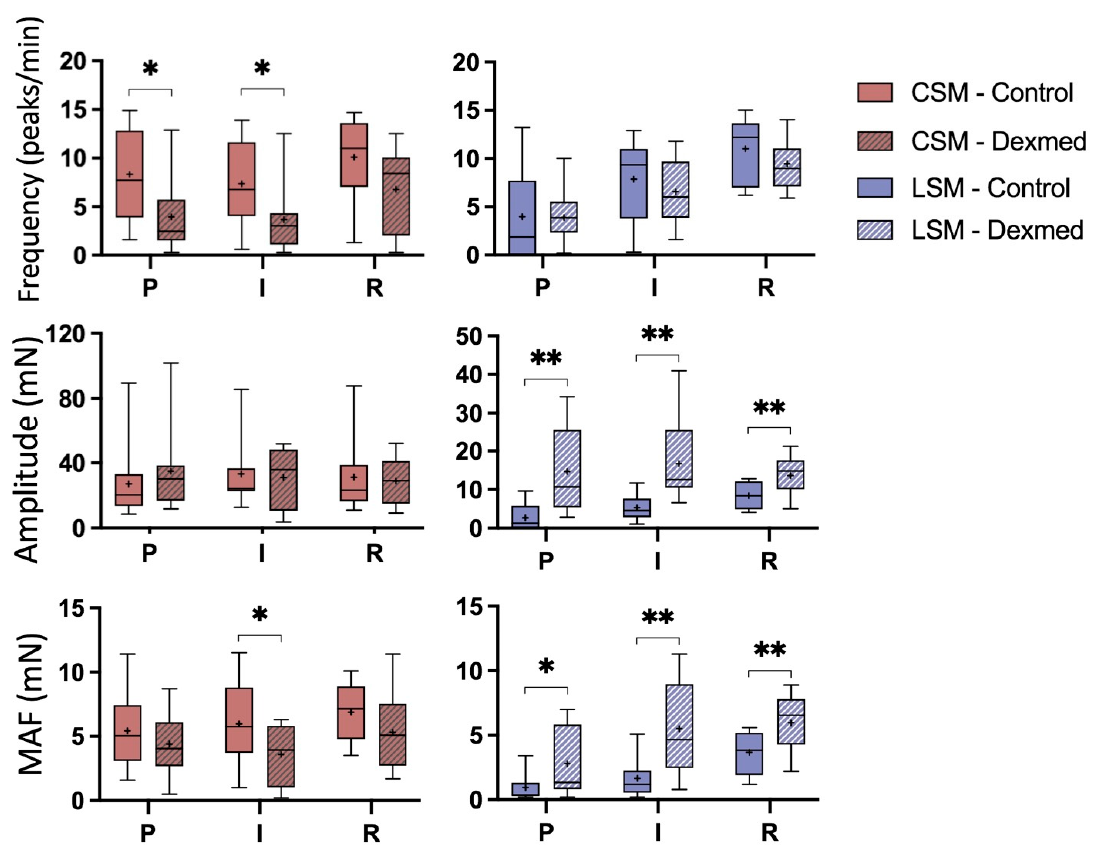
Figure 4. Box plot diagram of the basal contractile activity of jejunal circular smooth muscle (CSM) and longitudinal smooth muscle (LSM) with and without the addition of dexmedetomidine (Dexmed) during pre-ischaemia (P), ischaemia (I), and reperfusion (R) at t105–110. Significant differences between the control group and the Dexmed-treated group (two sampled t -test) are marked with an asterisk (* p < 0.05; ** p < 0.01). The horizontal bar displays the median and the plus is the mean, the interquartile range is represented by the box and the minimum and maximum by the whisker plots. MAF is the mean active force.